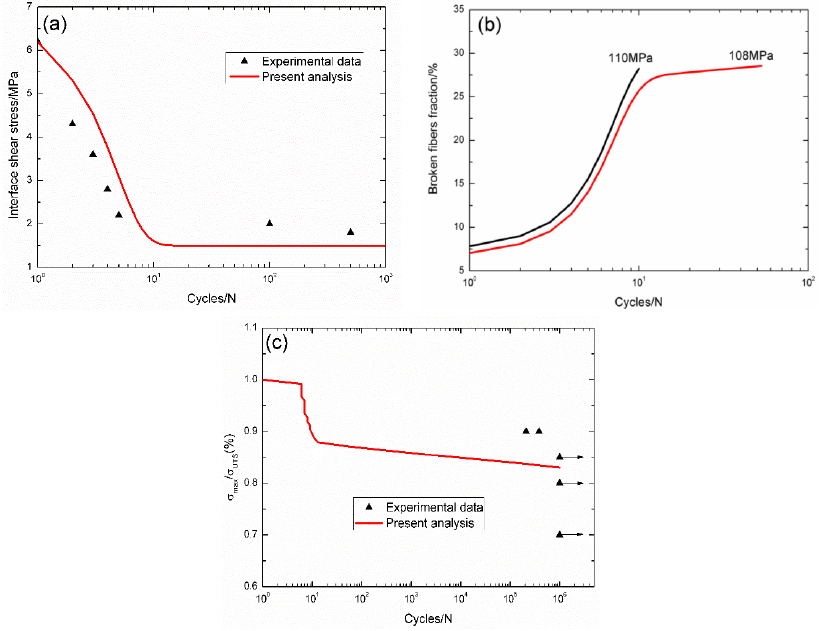
Figure 5. ( a ) The interface shear stress versus applied cycles; ( b ) the broken fibers fraction versus applied cycles; and ( c ) the fatigue life S–N curves of experimental data and theoretical analysis for cross-ply C/SiC composite at room temperature.